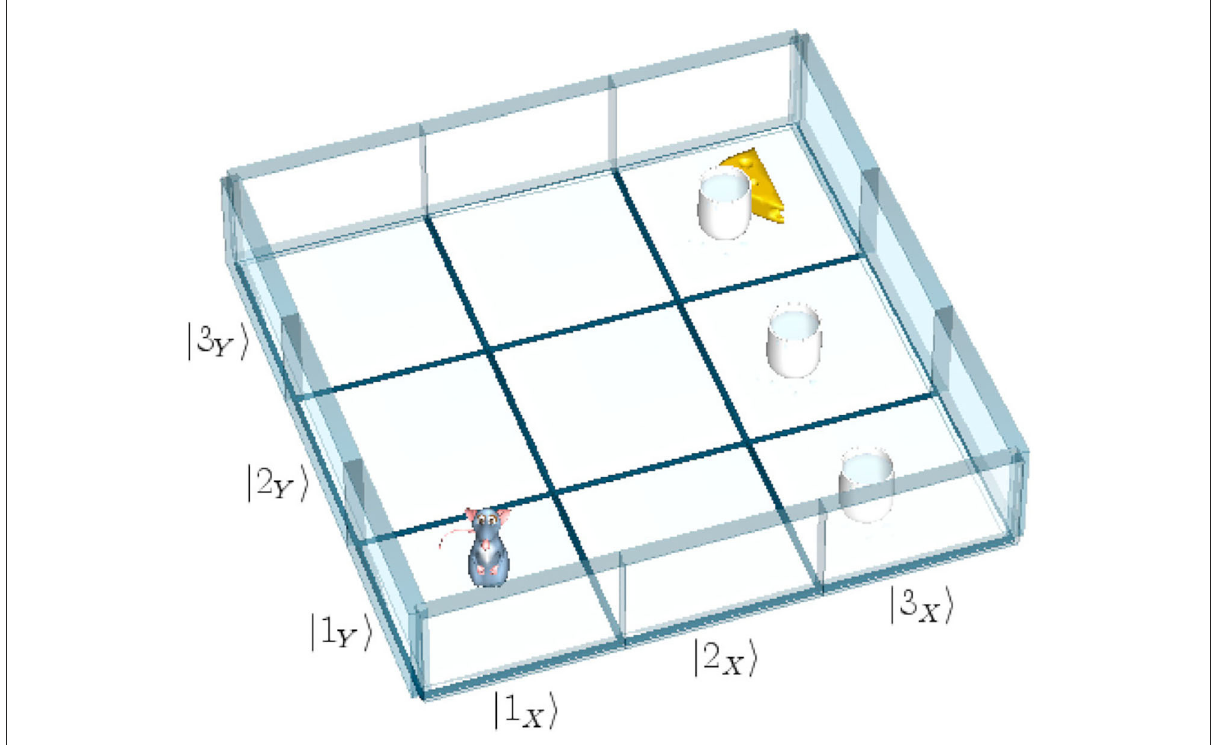
FIGURE7 Cognitive agent Theseus in a labyrinth with water and